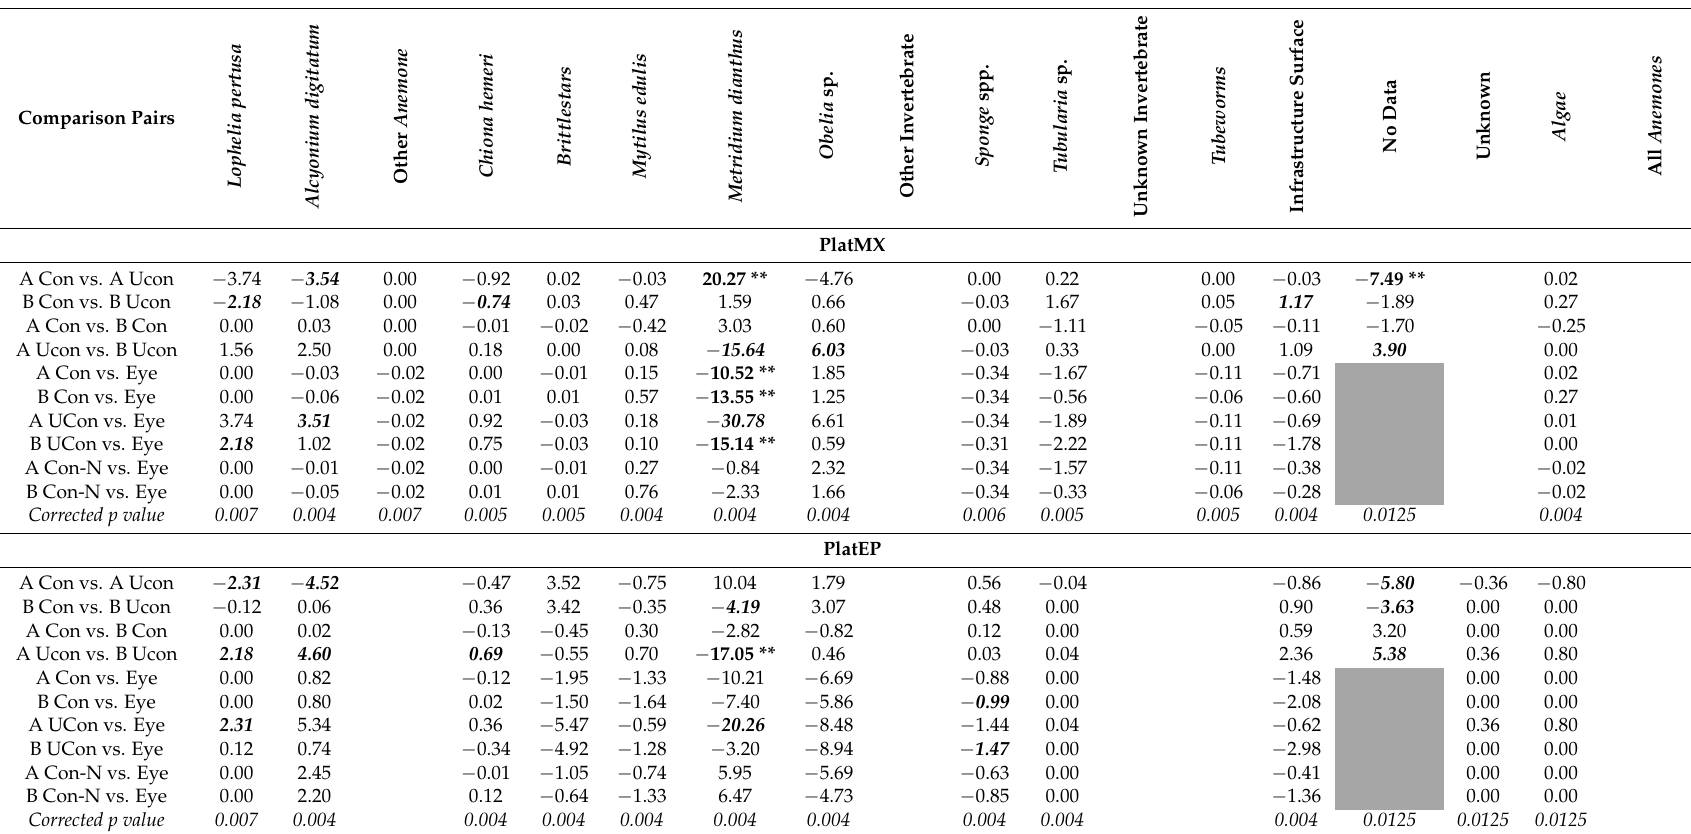
Table 4. Difference in means between comparison pairs, two-way paired Student t -Test comparison, with Bonferroni correction per species for all testing methods (A, B and C; Con = confirmed, Ucon = unconfirmed, Eye = manual, Con-N = confirmed-normalised) for each platform (PlatMX, PlatEP and PlatMS).